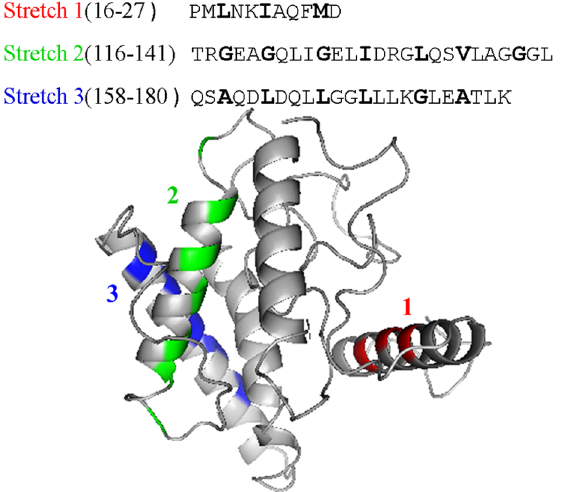
Fig. 5. Ribbon representation of the 3D structure of C-214-HrpZ Pss . Residues involved in leucine-zipper- like motif or coiled-coil motif are highlighted in red (stretch-1), green (stretch-2) and blue (stretch-3). Amino acid sequences of the leucine-zipper-like motif or coiled-coil motif at various segments of the protein are shown with putative leucine-zipper or coiled-coil forming residues highlighted in bold. Since 127 amino acids were deleted in C-214-HrpZ Pss , residue 128 was numbered as